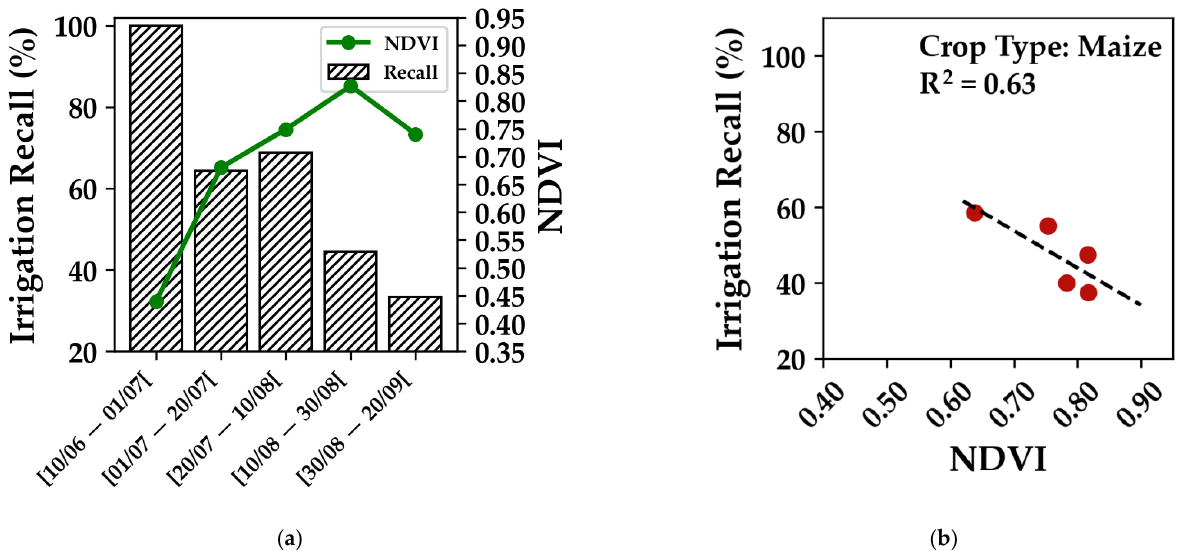
Figure 3. ( a ) Dynamics of recall in function of NDVI for Maize crops between September and June. Recall values as bar dashed plots with NDVI in green line; ( b ) recall values plotted against NDVI values. Each point corresponds to the average recall and NDVI, respectively, for the 20-day time interval between June and September.